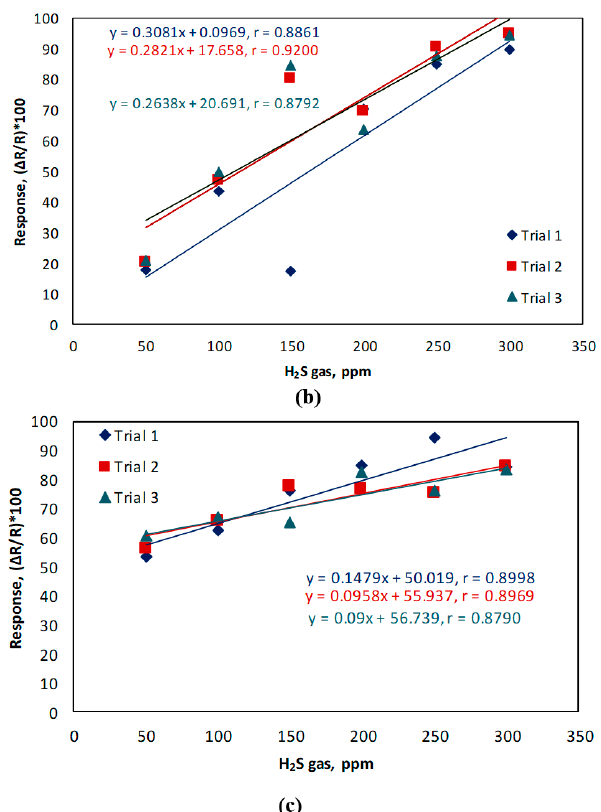
Figure 7. ( a ) A comparison of the calibration plots of electroactive PI/AuNPs-, and PANI/AuNPs-based chemiresistor gas sensors towards increasing concentrations of H 2 S gas (50 to 300 ppm, n = 3, RT). Repeatability studies based on the calibration plots of ( b ) PI/AuNPs, and ( c ) PANI/AuNPs.